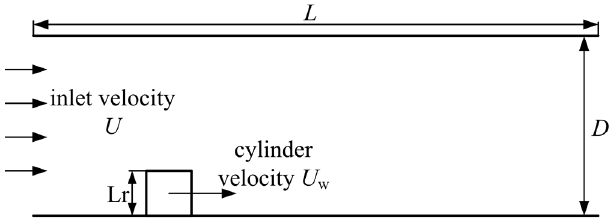
Figure 1. Physical model of moving square cylinder.